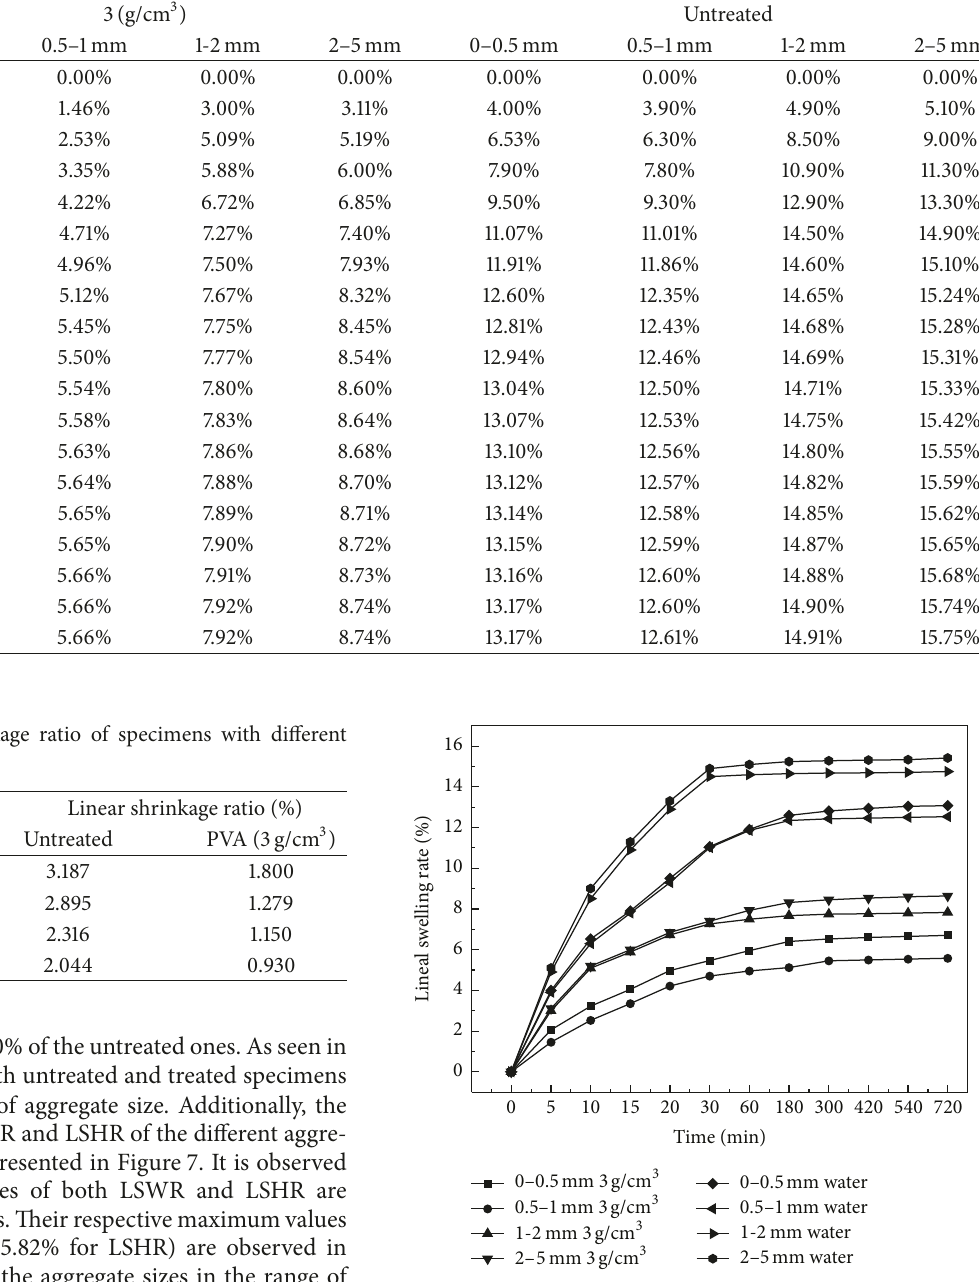
Figure 4: Variation of linear swelling ratio with immersed